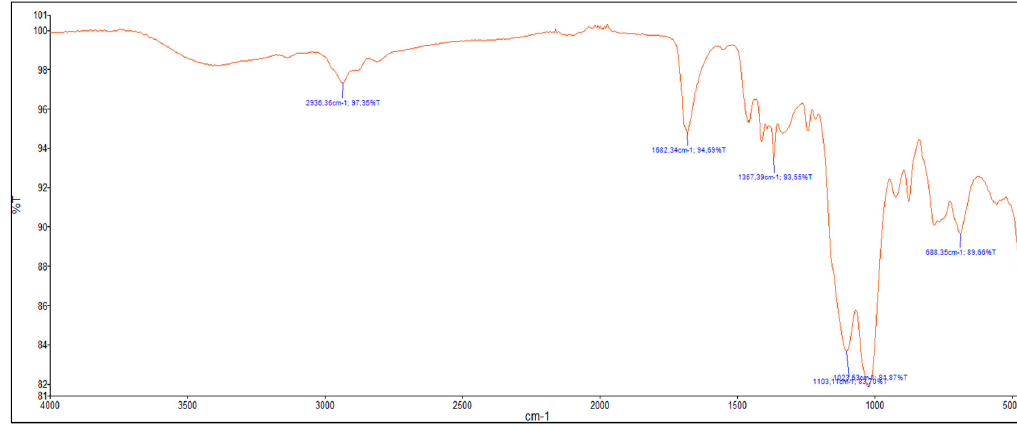
Figure 9. FTIR of P3 PMONPs .